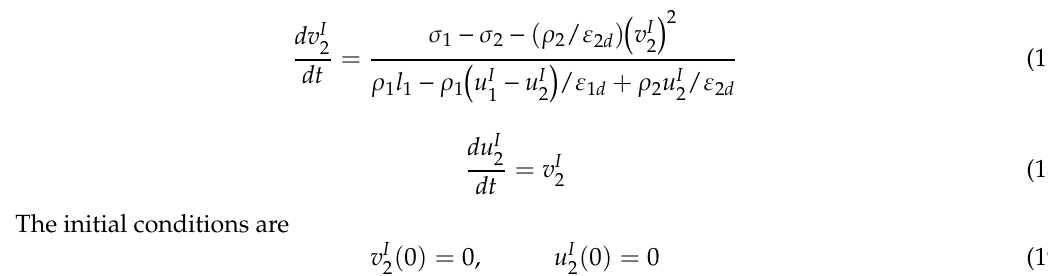
Figure 6. Stress analysis for a cylinder with a negative-gradient core in stage I. ( a ) The undeformed part of layer 1 and the compaction part of layer 2, and ( b ) the compacted part of layer 1. Substituting Equations (1), (14), and (15) into Equation (16) yields